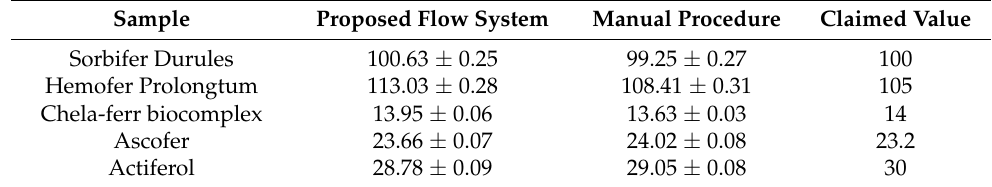
Table 1. Results of determination of Fe(II) in pharmaceutical preparations (iron content in mg per tablet, capsule or sachet). Results represent the average of at least four determinations ± S.D.